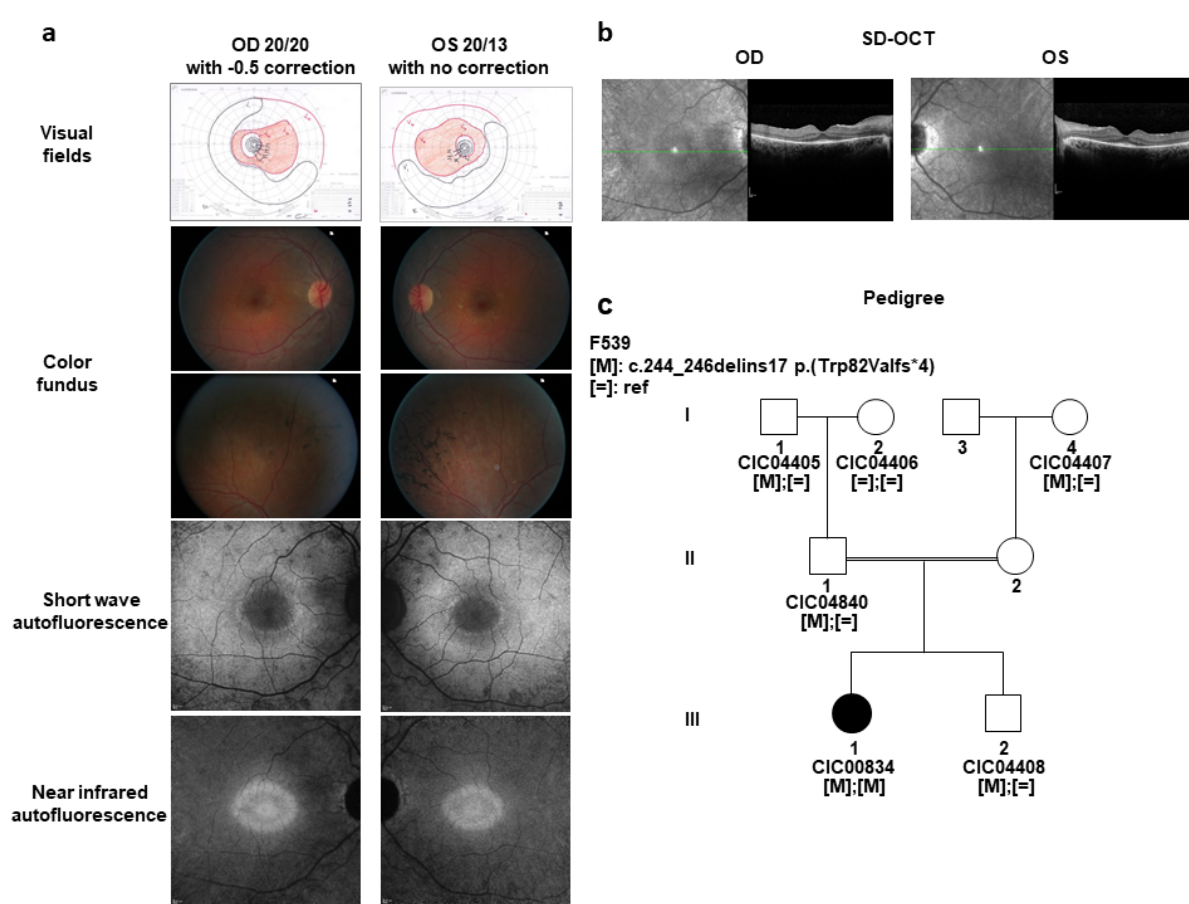
Figure 1. Clinical data and pedigree of a patient from a consanguineous family with rod-cone dystrophy. ( a ) Kinetic visual field show an annular scotoma for both eyes with relatively conserved peripheral isopters. Fundus color photographs show normal optic discs and retinal vessels with pigmentary changes in the periphery. Short- and near infrared wavelength fundus autofluorescence show a perifoveal ring of increased autofluorescence. ( b ) Spectral domain optical coherence tomography (SD-OCT) reveals well preserved outer retinal bands at the macula with outer retinal thinning in the periphery. ( c ) The affected girl (III.1) is homozygous for c.244_246delins17 p.(Trp82Valfs*4) [M] in CCDC51. The unaffected brother (III.2), the unaffected father (II.1), the unaffected paternal grandfather (I.1), and the unaffected maternal grandmother (I.4) are heterozygous for this variant, while the unaffected paternal grandmother (I.2) has no variant [=]. Circles represent female, squares represent male. Empty symbols indicate unaffected individuals, and the filled symbol affected individuals.